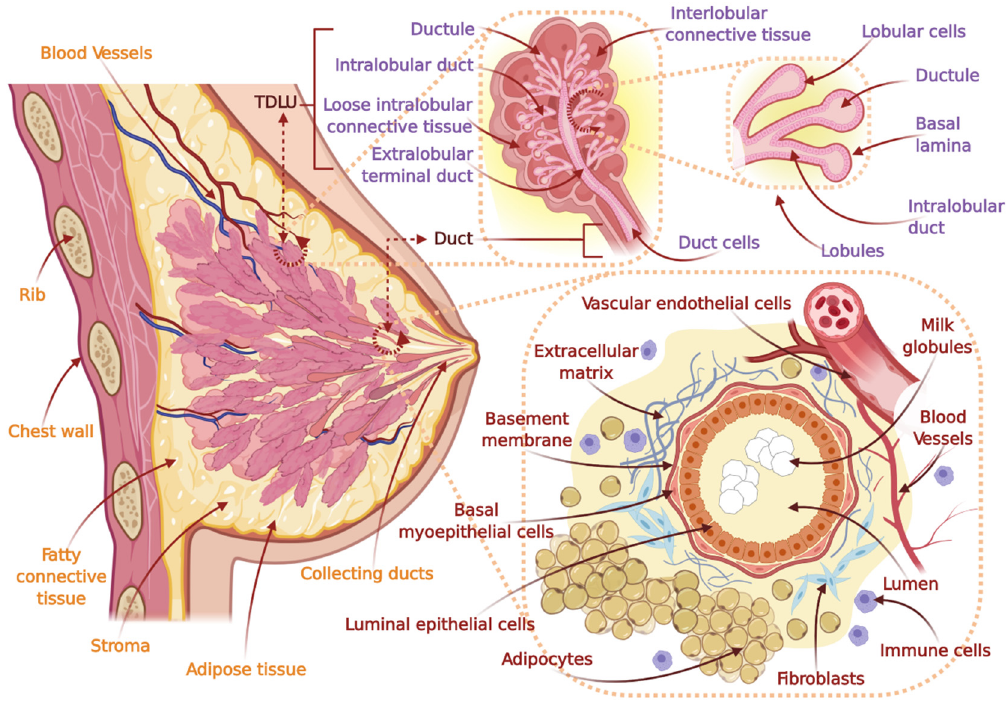
Figure 3. Schematic view of the human female breast and different types of interactive cells that are present within the breast tissue. The breast tissue overlays the ribs and chest muscles. The adult woman’s breast contains glandular epithelium (~10–15%) and this milk producing epithelia is contained within the surrounding adipose tissue. Multiple lobules (terminal ductules, acini, milk- producing lobules) together make up the lobes of the breast. The functional units of the breast are the terminal duct lobular units. All lobules and lobes are connected to the nipple through a branched system of ducts. Terminal ductal lobular units (TDLUs), which is a collection of ductules, intralobular duct, loose intralobular connective tissue, and extralobular terminal duct, are common sites of origin for several breast cancers. Within the stroma, two types of fibroblasts are present. Loosely connected intralobular fibroblasts surround the epithelial cells and they are subsequently encompassed by the more condensed interlobular fibroblasts. The other important cellular component of the mammary stroma is adipocytes (i.e., fat cells). The parenchymal tissue consists of epithelial and myoepithelial cells. In addition, the stromal compartment contains vascular endothelial cells and infiltrating immune cells. Stromal cells secrete factors of the extracellular matrix (e.g., collagens, hyaluronic acid, tenascins, fibronectins, proteoglycans) that are integral for the breast’s three-dimensional microstruc- ture. Mammary ducts consist of polarized apically orientated columnar luminal epithelial cells that line (inside) ducts along with alveolar structures at the ends, as well as contractile myoepithelial cells that are orientated basally. This is enclosed by the basement membrane (BM), which forms a physical barrier that separates the epithelial and stromal compartments. BM (i.e., basal lamina) mainly consists of laminin, collagen, entactin, and proteoglycans. Myoepithelial cells that possess contractile properties and stem cells (i.e., mammary repopulating units) comprise the functionally distinct basal layer. Constituents of milk are synthesized by secretory cells that forms the alveoli, followed by secretion into the alveolar lumen. Adapted from Refs.